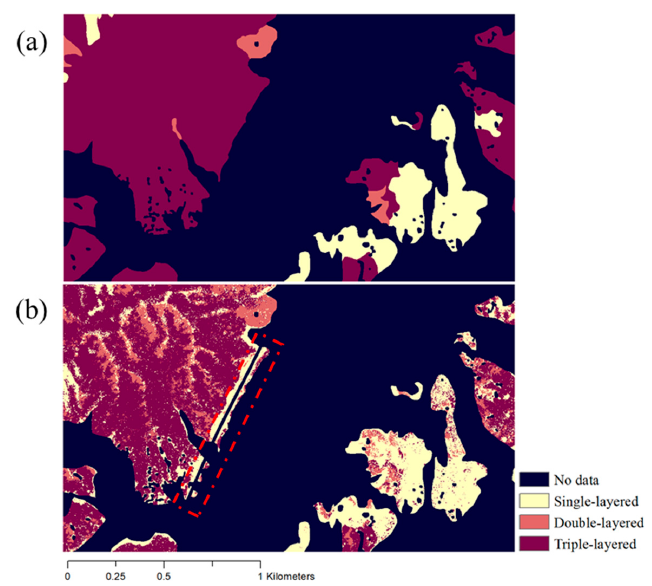
Figure 8. ( a ) Field survey classification map of forest vertical structure (same as Figure 2a); ( b ) final classification map of forest vertical structure using the ANN with red box -road way-.